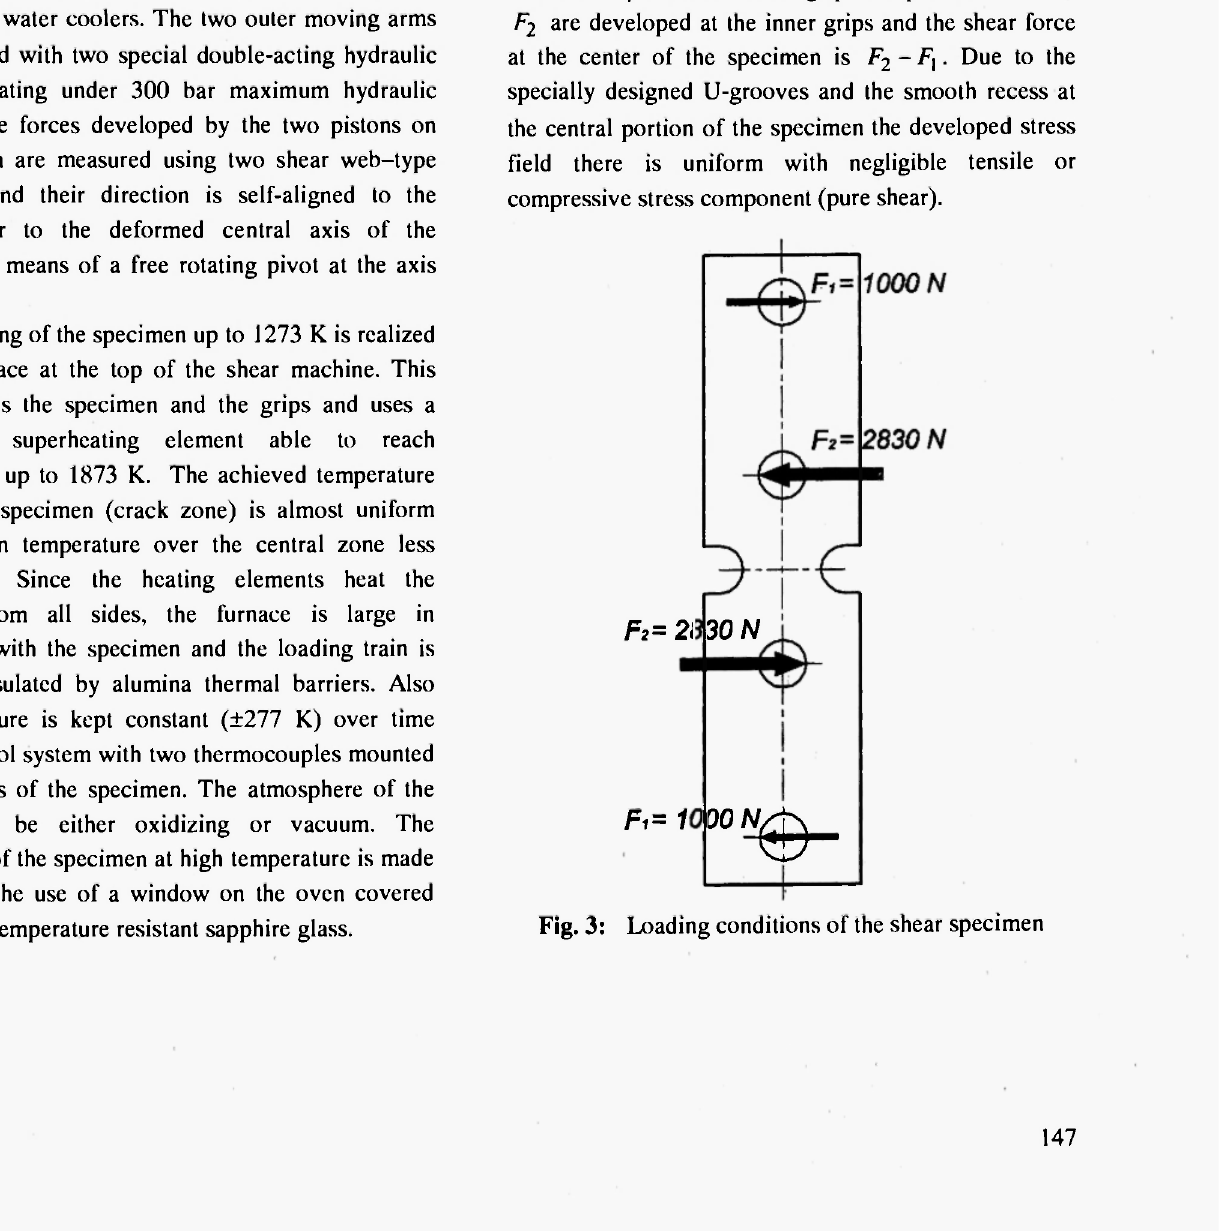
Fig. 3: Loading conditions of the shear